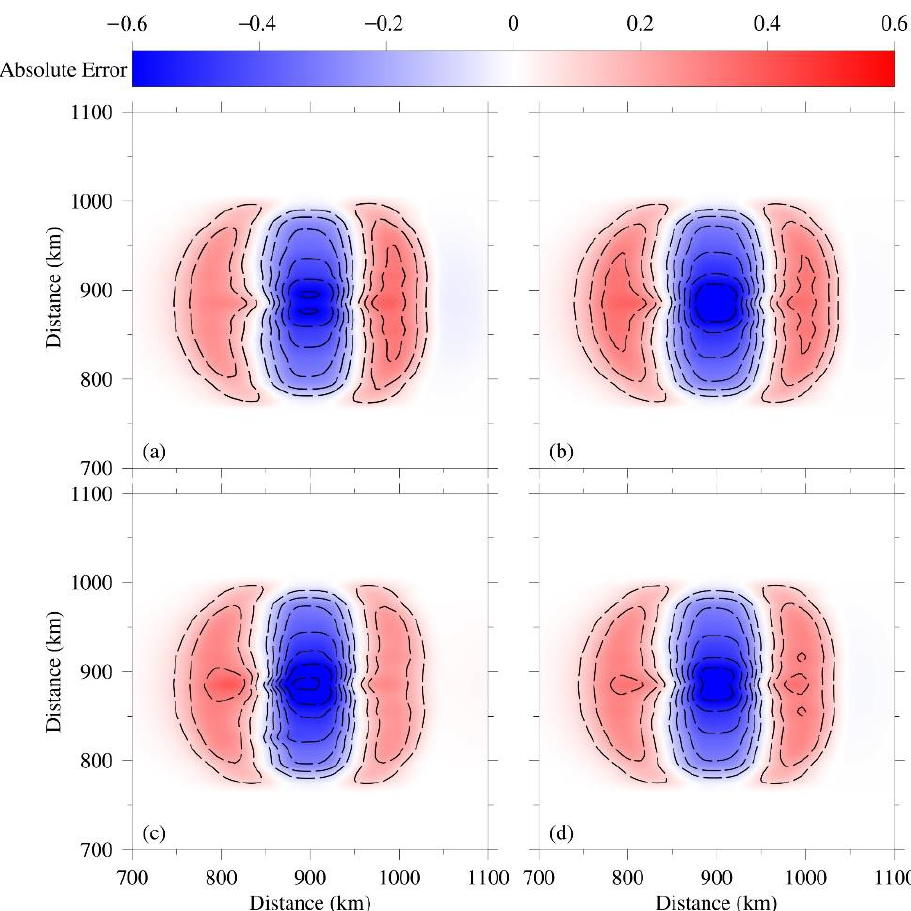
Figure 6. Distribution of absolute error at hour 212 of simulation for ( a ) upwind AEI scheme, ( b ) QI scheme, ( c ) HPI scheme, and ( d ) HSIMT AEI scheme. Contour interval is 0.1